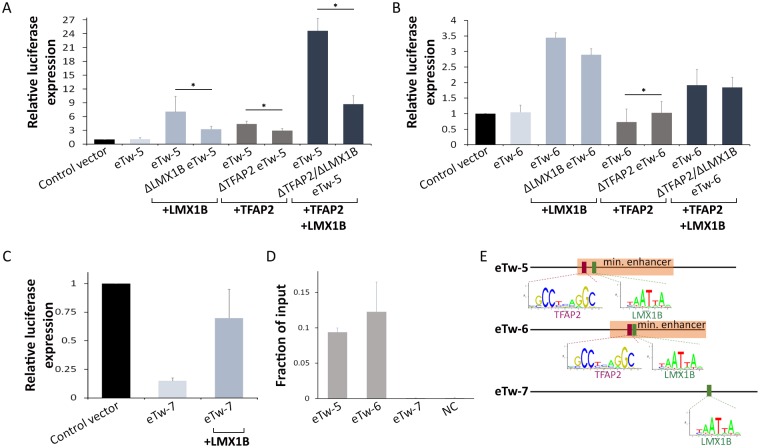
LMX1B and TFAP2 modulate TWIST1 enhancers.(A)
In vitro eTw-5 activity in HEK293T cells following co-transfection with LMX1B or TFAP2 (TFAP2α and/or TFAP2γ) expression vectors. Luciferase activity was measured for the eTw-5 sequence and for deleted LMX1B (ΔLMX1B), TFAP2 (ΔTFAP2) or both LMX1B and TFAP2 (ΔLMX1B\ΔTFAP2) binding sites from eTw-5 sequence. (B)
In vitro eTw-6 activity in HEK293T cells following co-transfection with LMX1B or TFAP2 (TFAP2α and/or TFAP2γ) expression vectors. Luciferase activity was measured for the eTw-6 sequence and deleted LMX1B (ΔLMX1B), TFAP2 (ΔTFAP2) or both LMX1B and TFAP2 (ΔLMX1B\ΔTFAP2) binding sites from eTw-6 sequence. (C)
In vitro eTw-7 activity in HEK293T cells following co-transfection with LMX1B expression vector. Luciferase activity was measured for the eTw-7 sequence and for LMX1B-deleted eTw-7 (ΔLMX1B). Relative luciferase expression results after normalization to Renilla activity are presented and represent the means ± standard deviation of three independent experiments (P-value<0.05, Student’s t-test). (D) ChIP-qPCR analysis of eTw5-7 with anti-TFAP2α antibodies in a mouse E11.5 limb bud. Fold enrichment is presented as a fraction of input. The error bars represent the SD from two technical replicates of a representative experiment. (E) A schematic representation of minimal enhancer sequences with the location of the predicted binding site for TFAP2 (red bar) and LMX1B (green bar) shown.